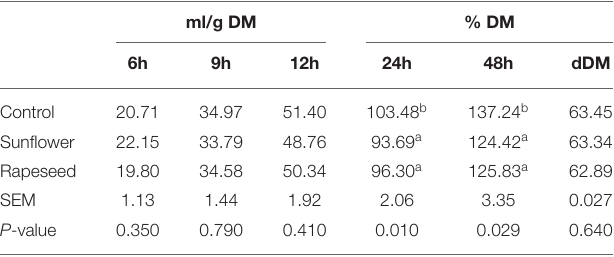
TABLE 4 | Total gas production at different time points and dry matter degradation